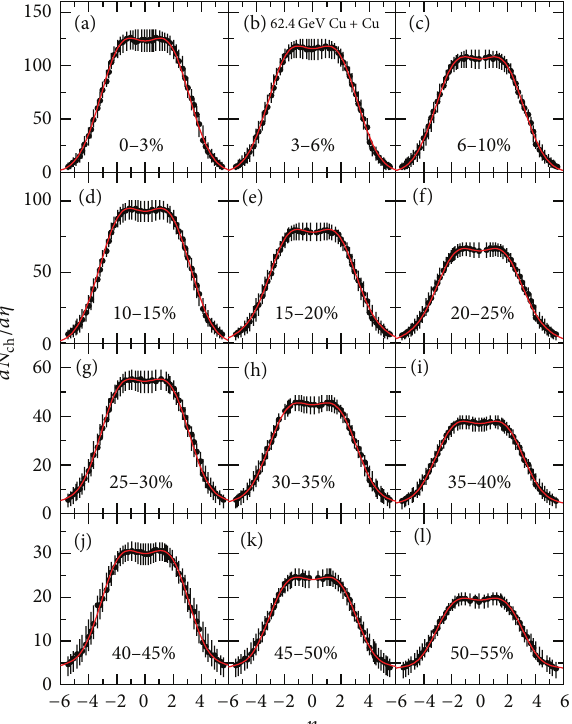
Figure 4: As Figure 1 but showing the results in Au-Au collisions at √𝑠 = 200 GeV. 𝑁𝑁